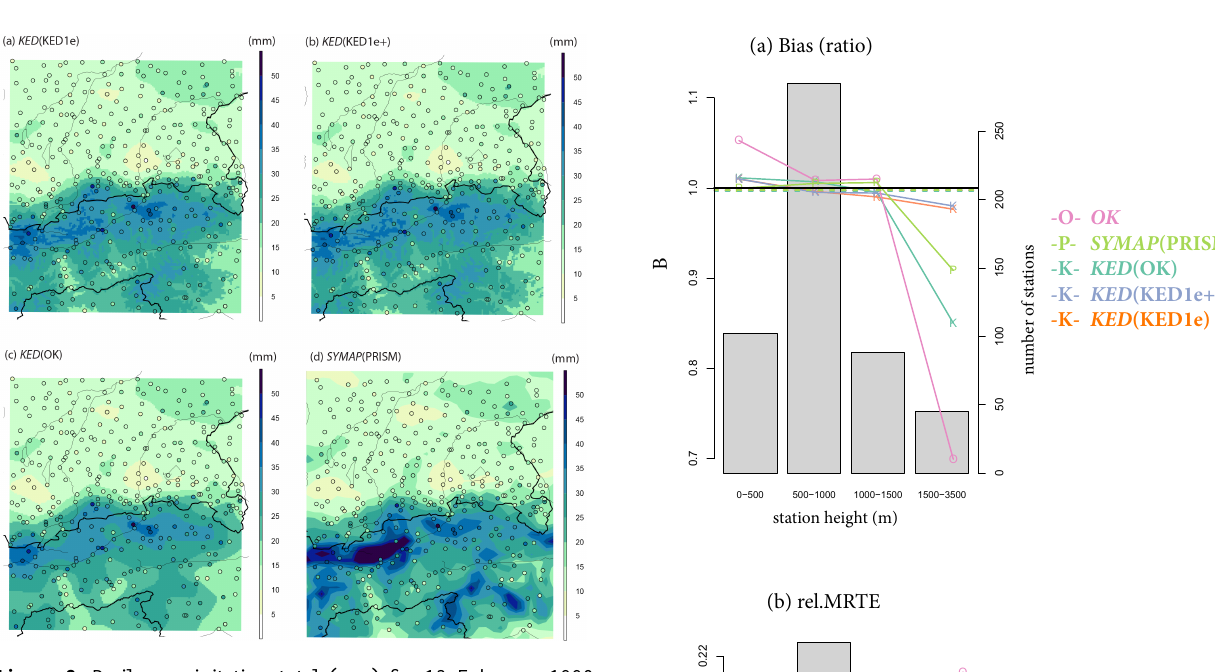
Figure 8. Daily precipitation total (mm) for 13 February 1990 as derived by the daily interpolation methods investigated in this study. (a) KED(KED1e), (b) KED(KED1e + ), (c) KED(OK), (d) SYMAP(PRISM); see Table 2 for a description of the method acronyms. The fields of (a–c) were produced on a 1km grid, and that of (d) on a 5km grid.